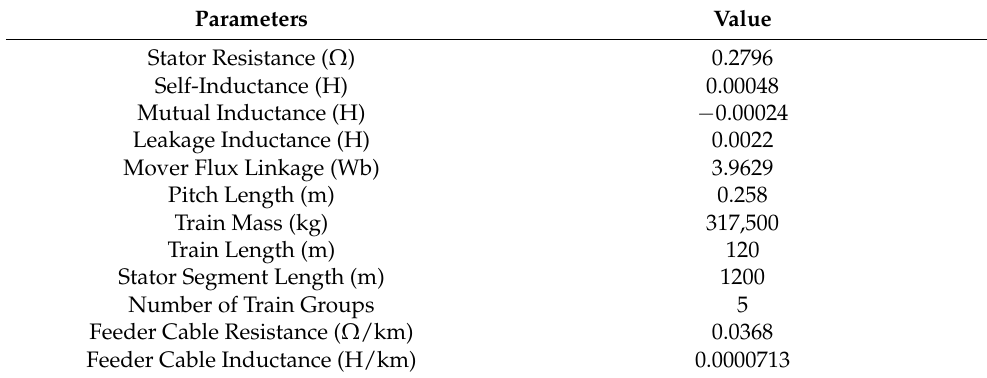
Table 1. The parameters of the linear